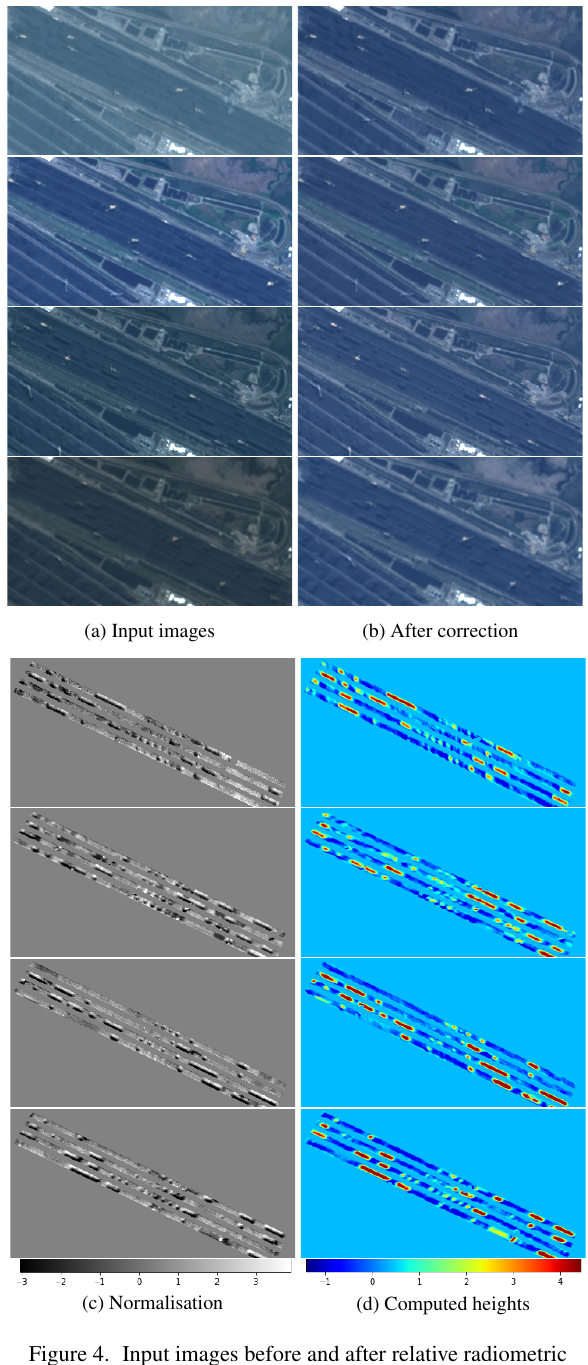
Figure 4. Input images before and after relative radiometric correction (Hessel et al., 2020) , normalised images and predicted heights from our shape-from-shading method for the first site ( 2 . 58 × 1 . 58